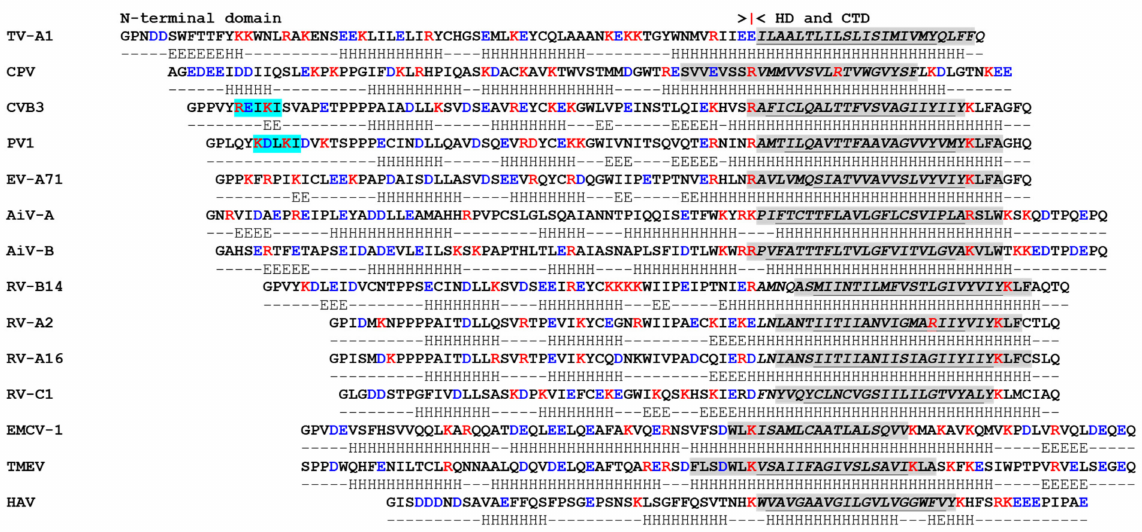
Figure 1. 3A protein alignment for selected picornaviruses. Alignment of full-length 3A proteins for selected picornaviruses; Enteroviruses, poliovirus 1 (PV1) (Enterovirus C), coxsackie virus B3 (CVB3) (Enterovirus B), enterovirus A71 (EV-A71) (Enterovirus A), rhinovirus A2 (RV-A2) and rhinovirus A16 (RV-A16) (Rhinovirus A), rhinovirus B14 (RV-B14) (Rhinovirus B), rhinovirus C1 (RV-C1) (Rhinovirus C); Kobuviruses, AiV-A1 (Aichivirus A), AiV-B1 (Aichivirus B); Cardioviruses, encephalomyocarditis -1 (EMCV-1) (Cardiovirus A), Theiler’s murine encephalitis virus (TMEV) (Cardiovirus B); Hepa- tovirus, hepatitis A virus (HAV) (Hepatovirus A); Limnipivirus, carp picornavirus (CPV) (Limnipivirus B); Teschovirus, TV-A1 (Teschovirus A). 3A proteins have a similar organisation that consists of a N-terminal domain, a hydrophobic domain (HD) that includes a predicted membrane-binding region (MBR), followed by a C-terminal domain (CTD). Here, the HD (shown in italics) is loosely defined as a region devoid of charged aa (note for RV-A2 and CPV a single R residue may be present in the HD). The 3A sequences are shown using the single letter aa code and were aligned using the first charged aa (marked by | ) before the putative HD (note, for TV-A1 there is no charged aa after the HD). Charged aa are shown in bold red (R and K) or bold blue text (D and E). Transmembrane binding regions were predicted using TM-PRED [90], TMHMM [91], PHOBIUS [92] and HMMTOP [93]. Grey boxes highlight the aa with the potential to form an MBR identified by at least one of the programs. For some viruses, some programs predicted that the MBR extended beyond the charged aa that flank the HD. Amino acids that were identified by all four programs are underlined and are likely to be involved in forming an MBR. For PV this includes the residues 65-AVTTFAAVAGVVYVMY-80 that were determined experimentally as the MBR by [94]. Note for EMCV-1 and CPV only 3 (TM-PRED, HMMTOP and PHOBIUS) and 1 (TM-PRED) program, respectively, predicted an MBR and therefore, for these viruses, no underlined sequences are shown. The residues that form the Golgi Brefeldin A Resistant Guanine Nucleotide Exchange Factor 1 (GBF1) binding site (residues 6-10 for CVB3 and PV) [95,96] are boxed in light blue. Note that these residues are mostly absent for RV-A2 and RV-A16, and the conserved K-9 (CVB3 and PV) is E-8 in RV-B14. Secondary structure predictions were made using Jpred4 and are indicated under each sequence (H = Helix, E = extended). Accession numbers of the sequences shown: PV1 V01149, CVB3 M88483, EV-A71